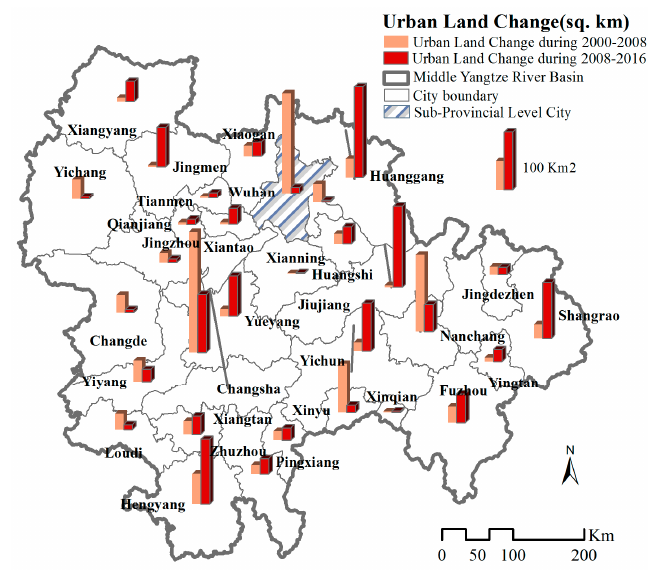
Figure 7. Expansion of urban land of the 31 cities in the MYRB from 2000 to 2016.